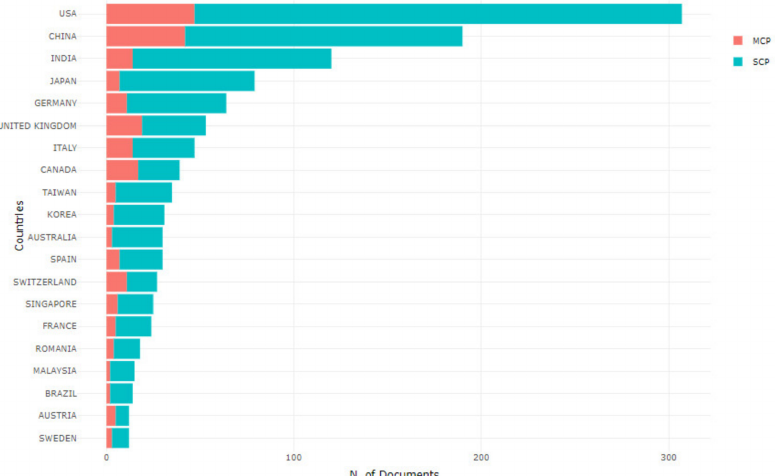
Figure 2. Countries of the corresponding authors with the biggest contribution to the explored topic according to Scopus and collaboration